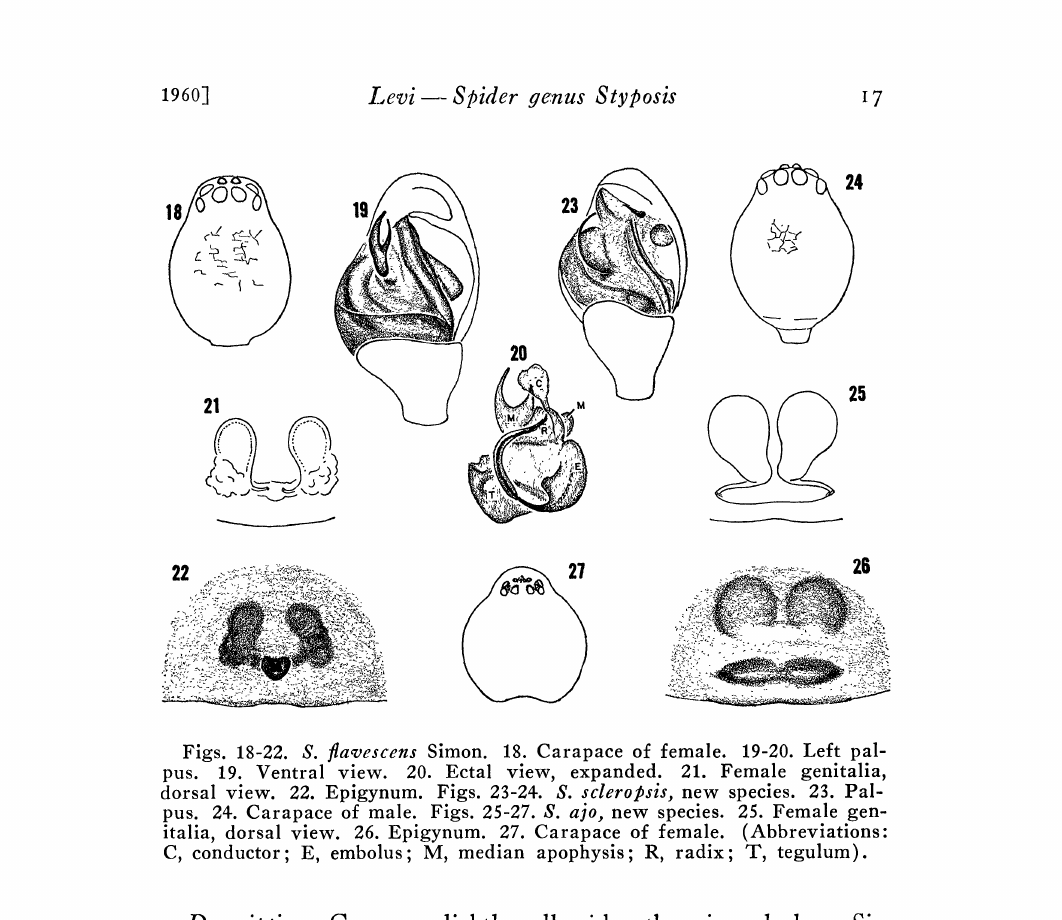
and tibia, 1.95 mm.; metatarsus, .33 mm.; tarsus, o.52 mm. Second patella and tibia, 1.14 mm. third, o.73 mm. ourth, 1.o6 mm. o the Diagnosis. The arrangement eyes (Fig. and genitalia (Fig. 2) separate this species from